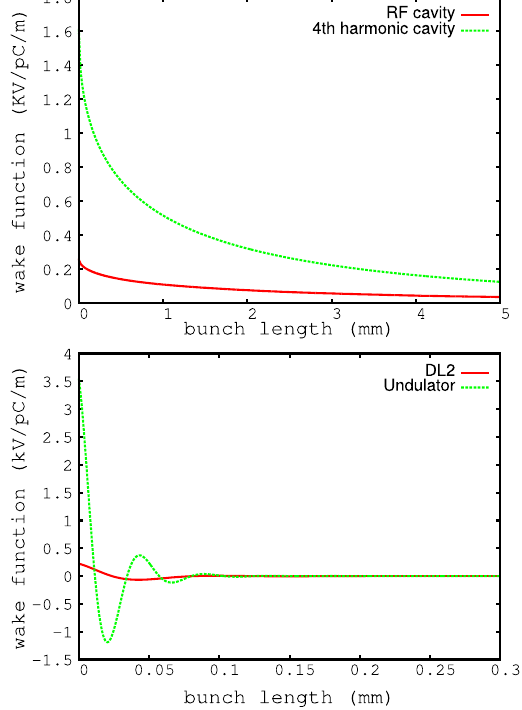
FIG. 1. The rf cavity structure wake function (top) and the resistive wall wake function (bottom) used in the